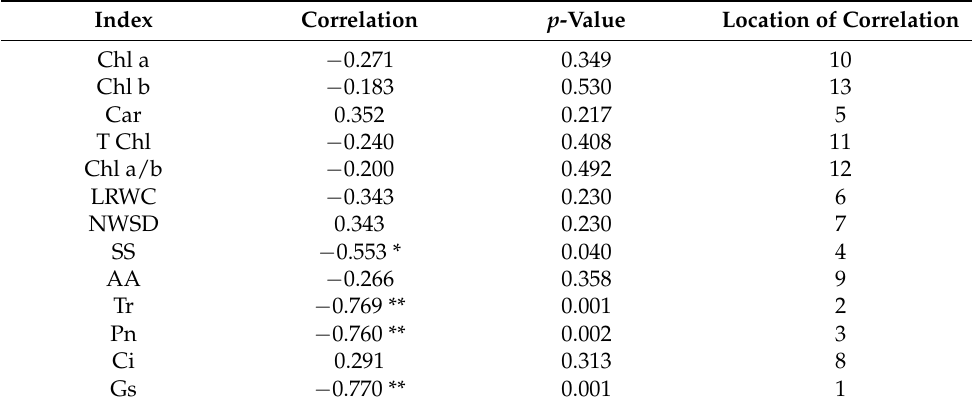
Table 3. Pearson’s correlation analysis between physiological indexes and